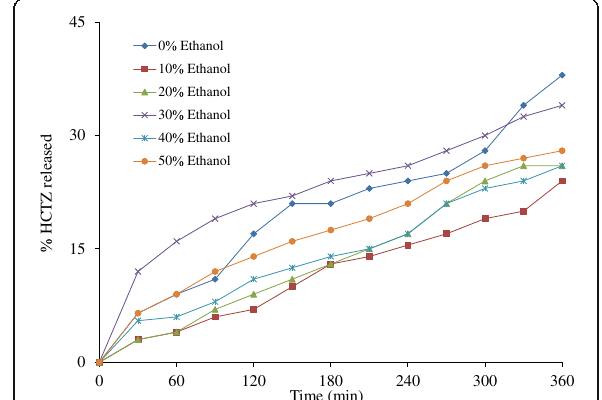
Fig. 13 Effect of ethanol concentration on the release profile of HCTZ from Carbopol71G tablet (data from reference (Emeje et al.